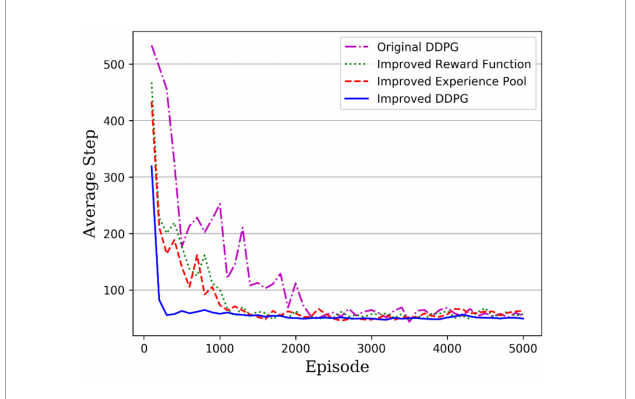
FIGURE11 Average stride length per 100 rounds of